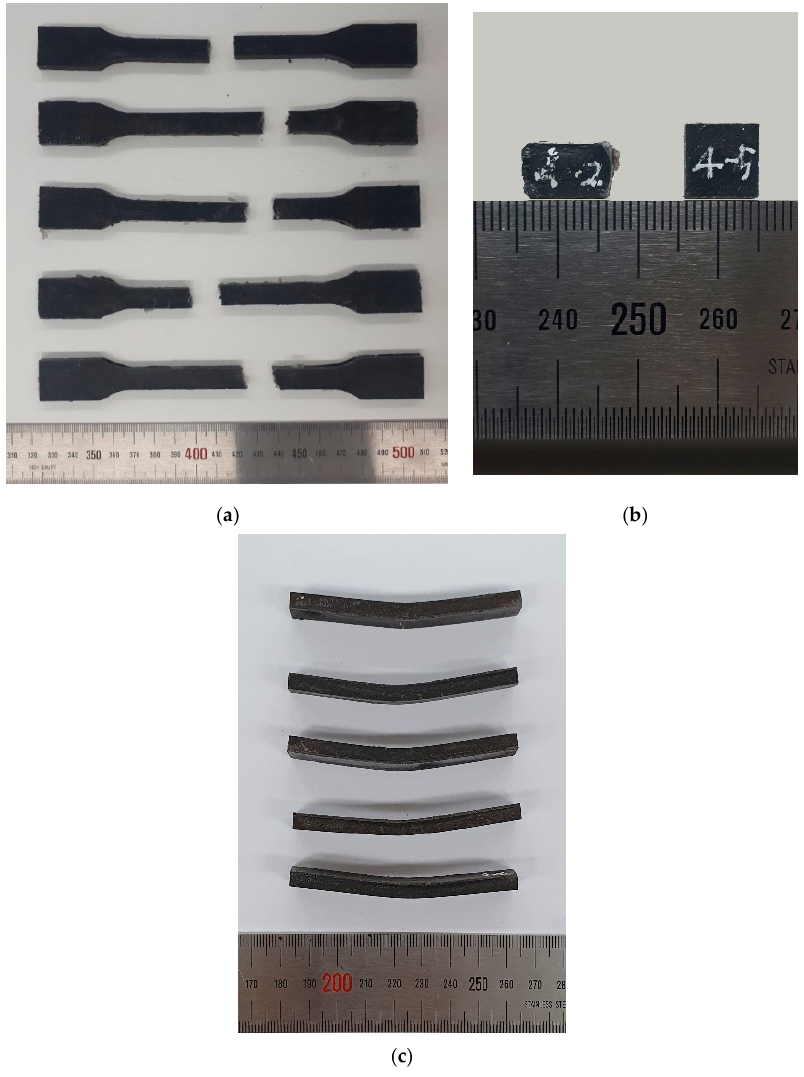
Figure 8. Examples of tested specimens: ( a ) tensile test, ( b ) compressive test and ( c ) flexural test. Table 7. Summary of tensile properties of the tested composites.